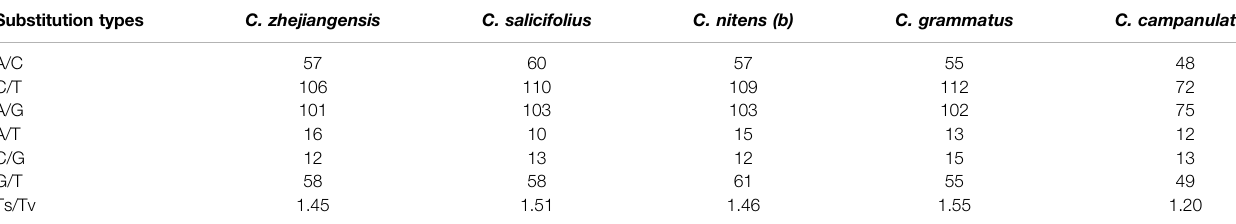
TABLE 2 | Comparison of transition and transversion mutations in Chimonanthus